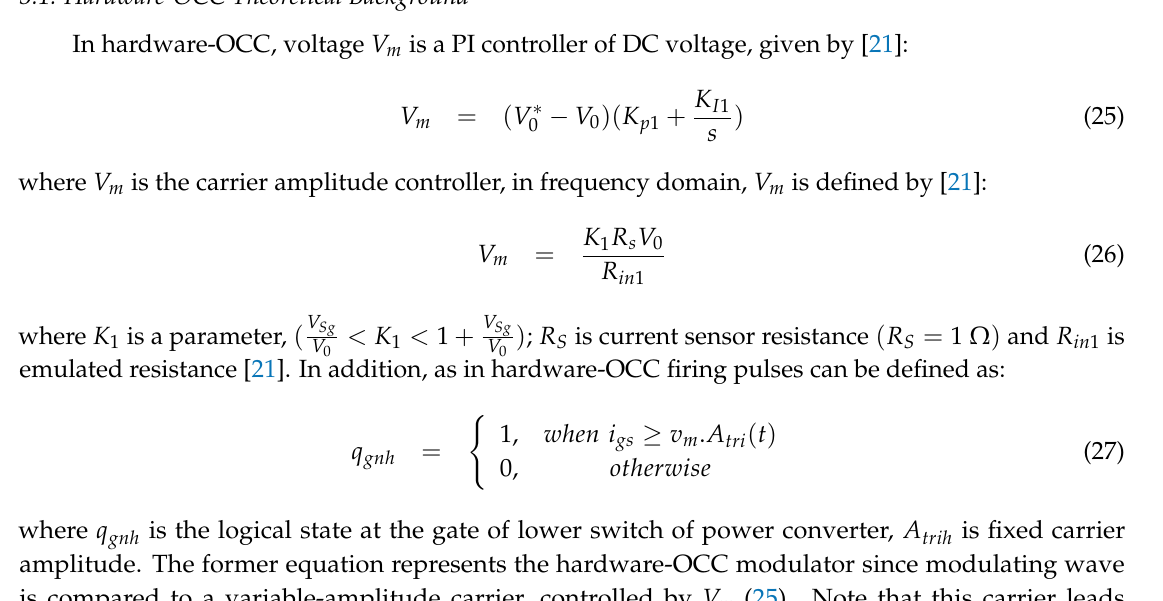
max and minimum R in −